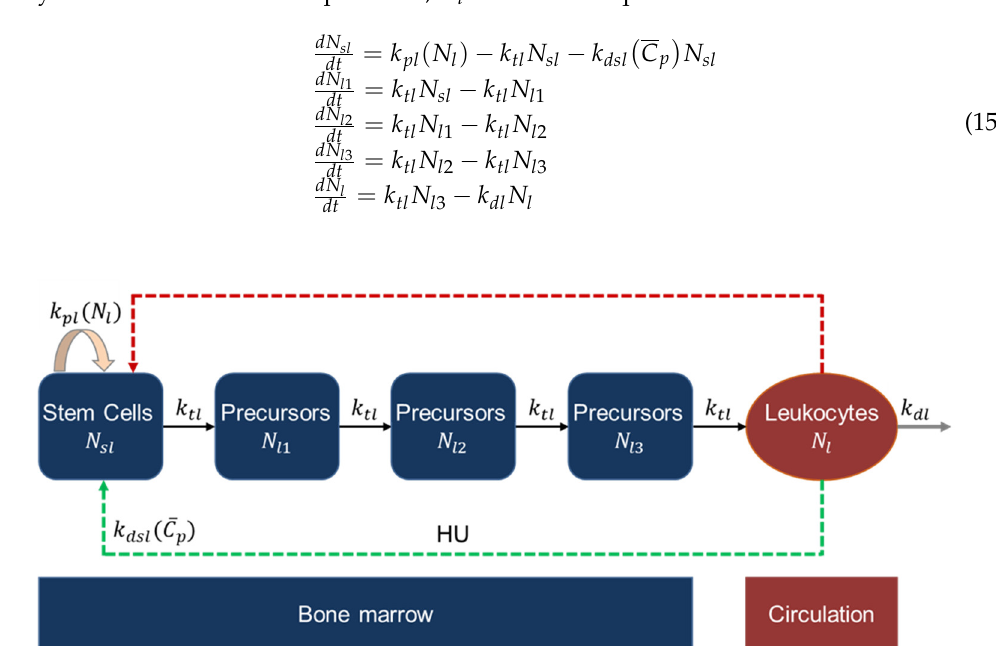
Figure 6. Schematic of leukopoiesis model. The dashed red arrow represents negative feedback regulation from the circulating cells; the dashed green arrow represents HU-related effect.